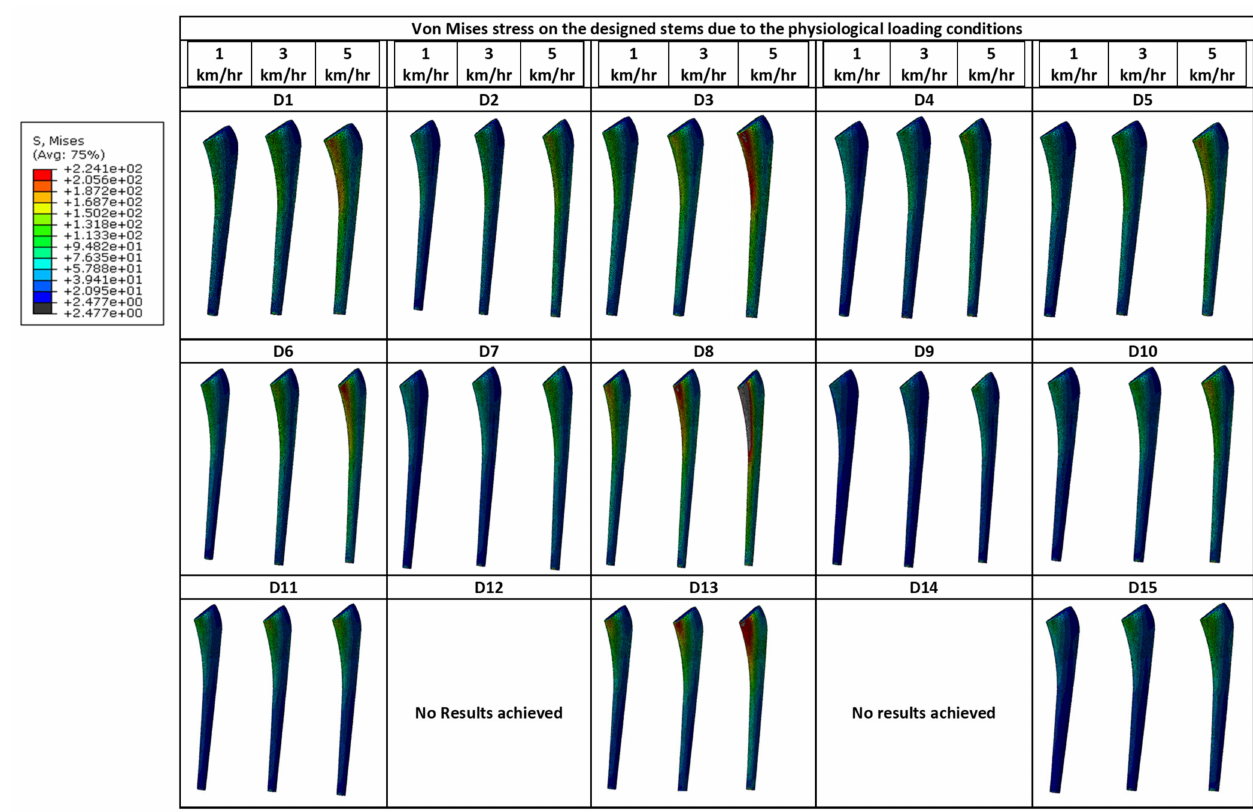
Figure 4. Von Mises stress obtained from the FEA for the fifteen designed stems planted inside the femur and subjected to the three physiological loads (1 km/hr, 3 km/hr, and 5